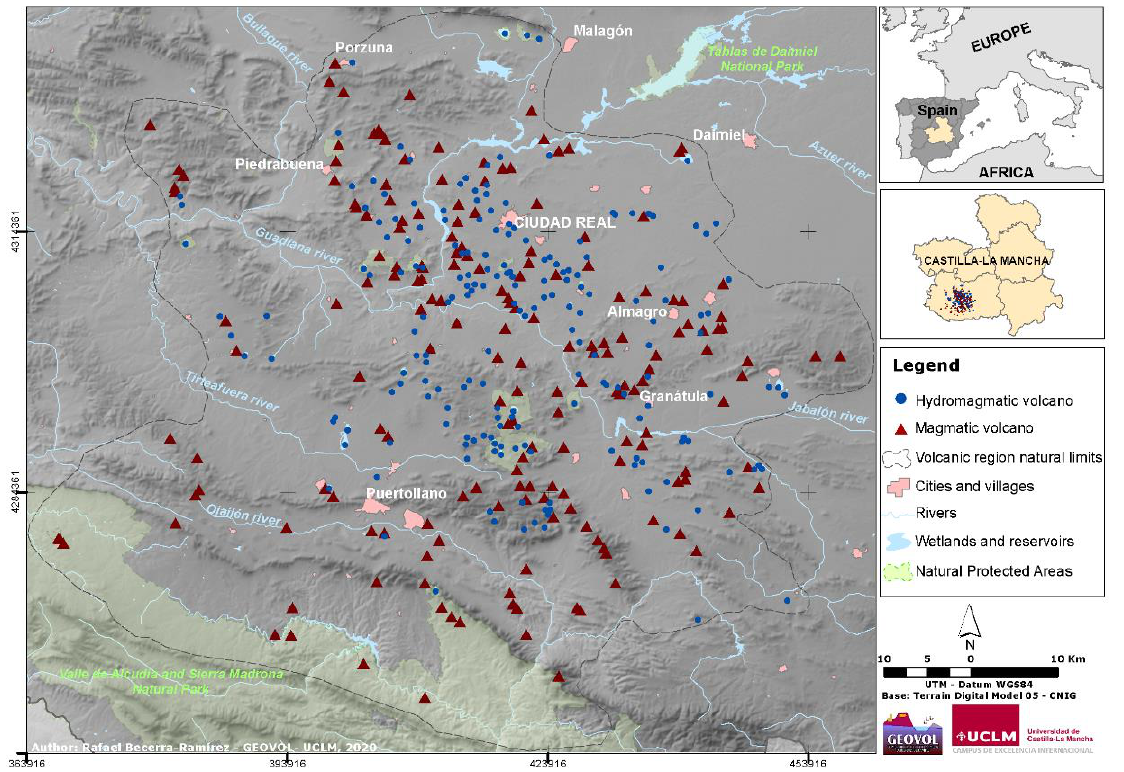
Figure 1. Study area and distribution of volcanoes in the Campo de Calatrava Volcanic Region (Ciudad Real province, Castilla-La Mancha, Spain).